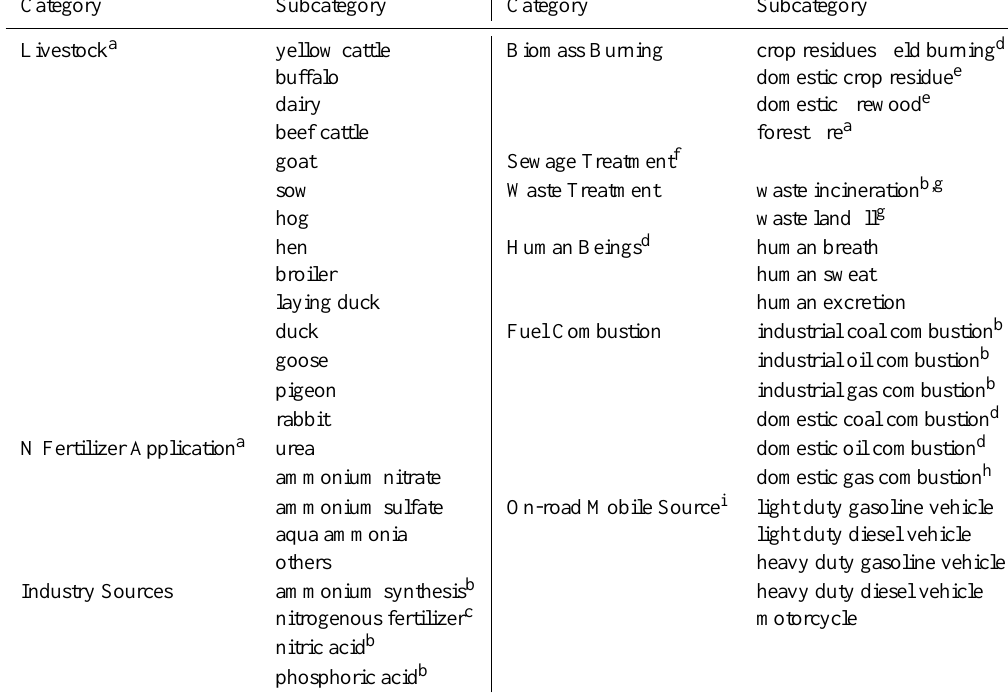
Table 1. Anthropogenic NH 3 emission source categories and data sources.